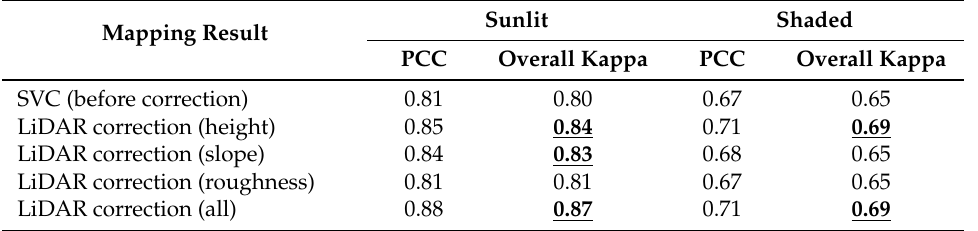
Table 2. Summary of level 2 sunlit-shaded overall accuracy results (overall kappa and PCC) for Support Vector Classification and for each LiDAR post-classification correction. Bold underlined values indicate significantly higher kappas (z = 0.05) compared to SVC before